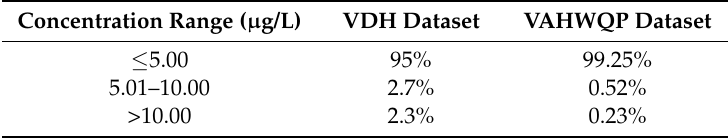
Table 2. Concentration ranges for each dataset and their respective